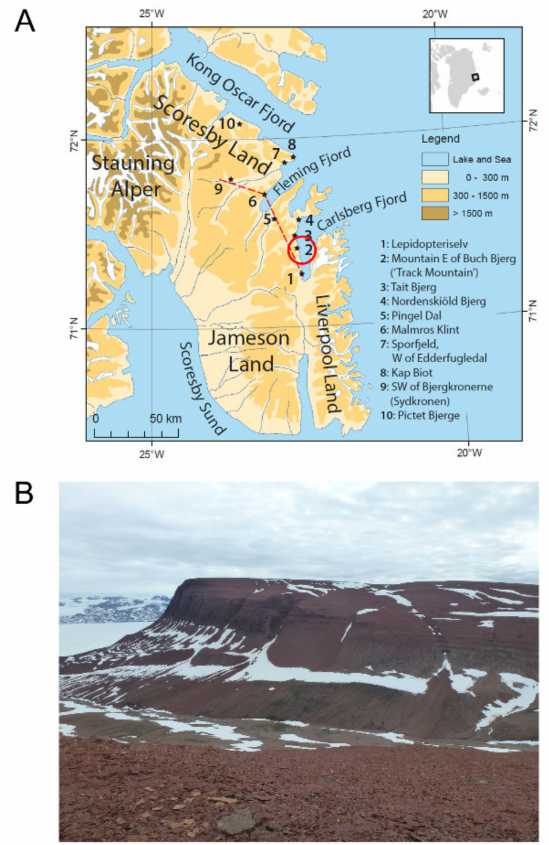
Figure 1. Topographic map of Jameson Land, central East Greenland. ( A ) Topographic map of Jameson Land. The Macknight Bjerg site of the Malmros Klint Formation is marked by the red circle and number 2. Modified from [25]. ( B ) Photograph of the outcrops in Buch Bjerg